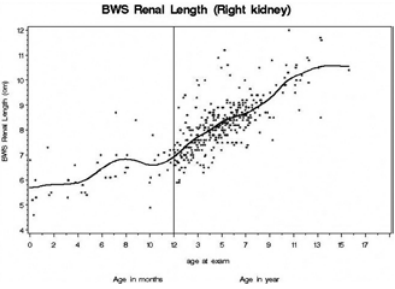
Figure 4 - Growth pattern of kidneys (right and left) for patients with Beckwith-Wiedemann syndrome (BWS). There was no significant difference in the patterns of growth for the right and left